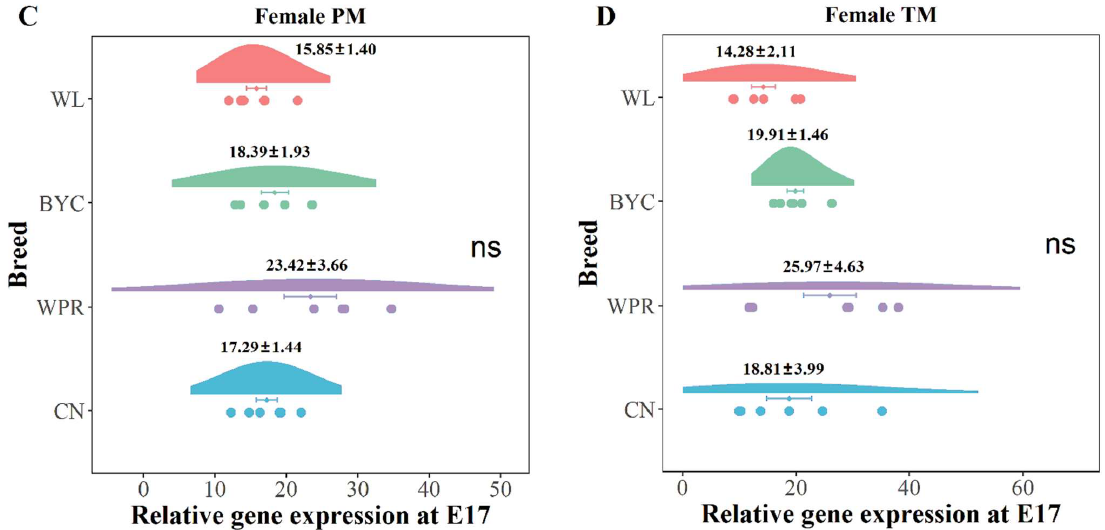
Figure 4. Gene expression of MSTN among various chicken breeds at E17. ( A ) Gene expression differences of MSTN in the PMM among the four chicken breeds at E17. ( B ) Gene expression differences of MSTN in the TMM among the four chicken breeds at E17. ( C ) Gene expression differences of MSTN in the PMF among the four chicken breeds at E17. ( D ) Gene expression differences of MSTN in the TMF among the four chicken breeds at E17. **, *, and ns represent adjusted p values < 0.01, <0.05, and >0.05, respectively.